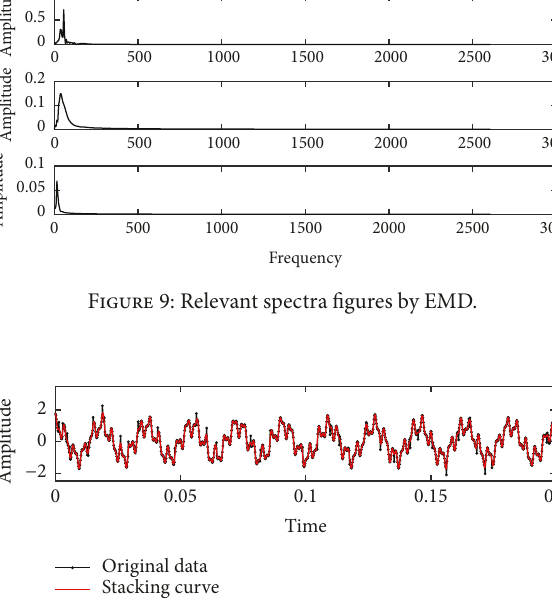
Figure11:OutlierdetectionresultsbyimprovedVMDforsimulated data.